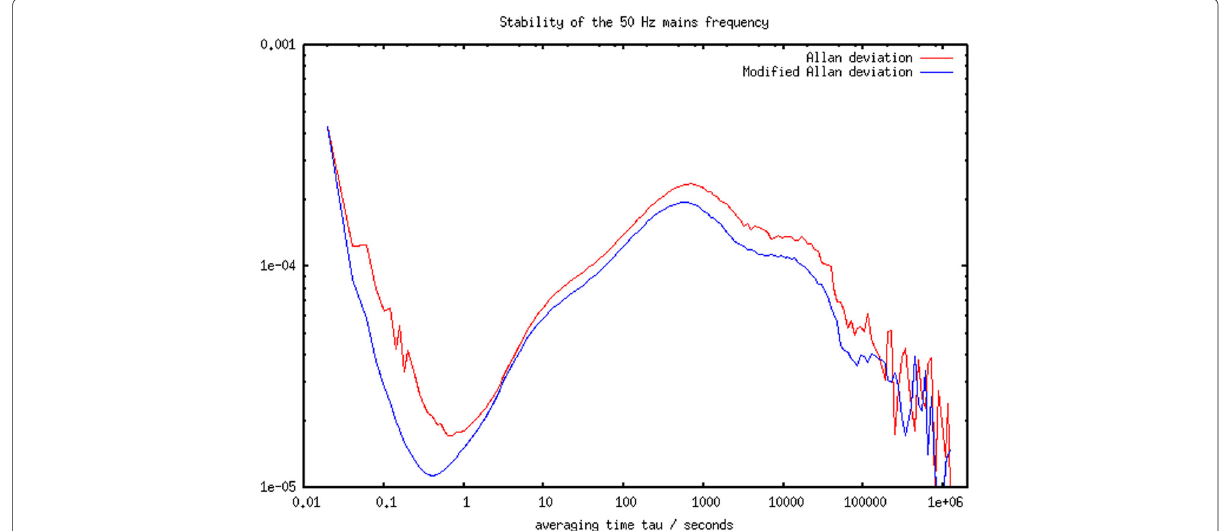
Fig. 3 Stability of network frequency (log-log plot of Allan deviation). Source: